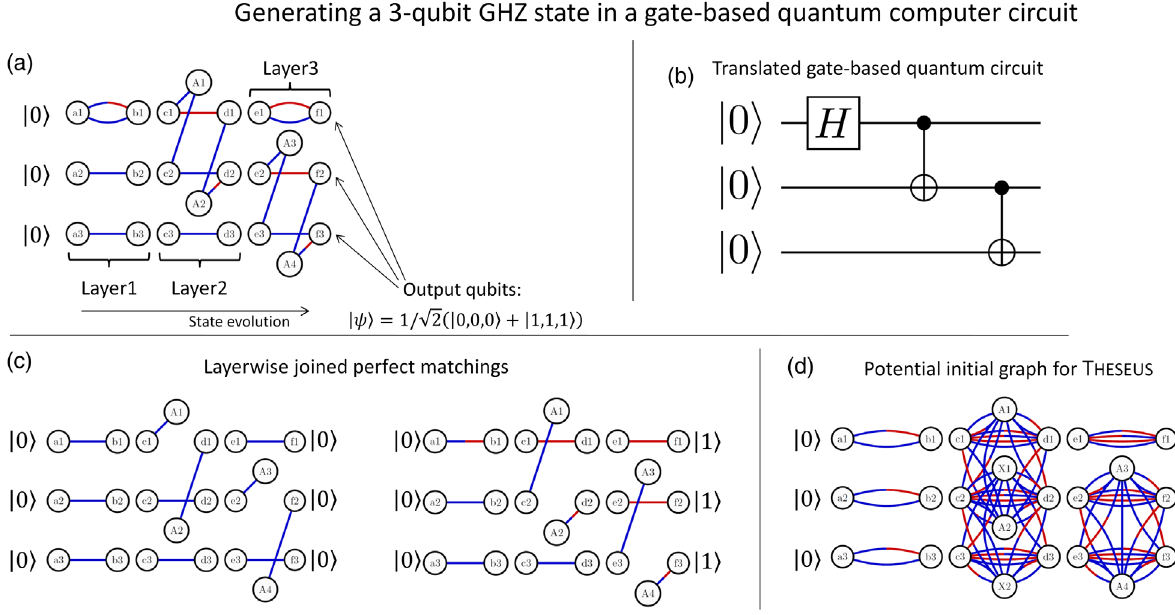
FIG. 6. A quantum circuit for creating a three-qubit GHZ state, represented using graphs that can be optimized by T HESEUS . In this concrete case, the graph in (a) represents a quantum circuit that transforms the initial state j 000 i to a three-qubit GHZ state ffiffiffi p 1 = 2 ðj 000 i þ j 111 iÞ [circuit in (b)]. In (a), every row stands for a qubit, and blue (red) edges stand for j 0 i ( j 1 i ). The vertices a i stand for the input values of the qubit; in this example, all are initialized into j 0 i . The quantum state evolves from left to right. The vertices b are i − d − f the final state of layer 1, c and e are the initial and final quantum information states of the second and third layer, respectively. i i i i The vertices A stand for ancilla vertices to represent control operations between the qubits. The evolution of the state is computed via i perfect matchings in the individual layers. The perfect matchings from the layers are then joined; the final state of layer n and the initial state of layer ( n þ 1 ) need to match. That is because the quantum information cannot change between layers. With this straightforward recipe, we find that there are exactly two joined perfect matchings in the graph, shown in (c). In the left one, all qubits remain in their initial state j 000 i . In the right one, qubit 1 is changed to state j 1 i in layer 1; subsequently, qubit 2 is changed to j 1 i in layer 2, and qubit 3 is changed to j 1 i in the final layer. In this way, the state emerges in j 111 i . As before in the photonic case, the full state is a coherent ffiffiffi p 2 superposition of all perfect matchings. For that reason, the final state is 1 = ðj 000 i þ j 111 iÞ , which is a three-qubit GHZ state. This representation can be used for designing nonphotonic gate-based quantum circuits using T HESEUS . We start with a general weighted graph, such as (d). Here, qubits can interact with each other only through ancilla vertices; therefore, there are no edges between the qubits from different rows. The first layer allows for single-qubit transformations. The second layer encodes two control operations, one between qubits 1 and 2 and one between 2 and 3. We choose to use only one control operation in layer 3 (to see the allowed structure more